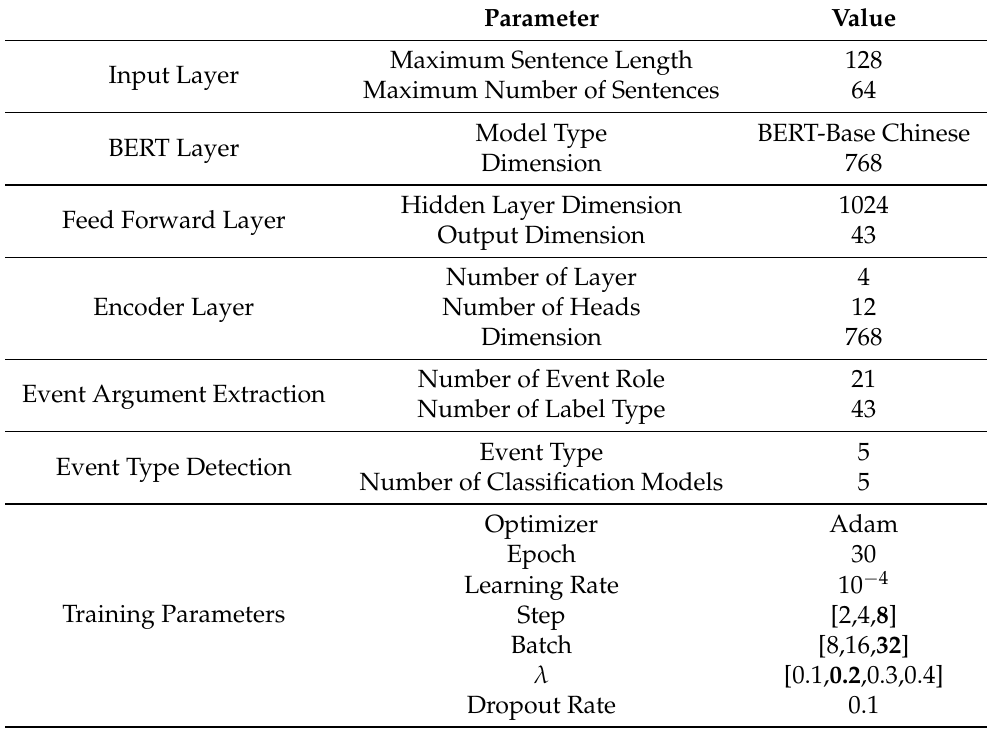
Table 3. Hyperparameters in the TDJEE